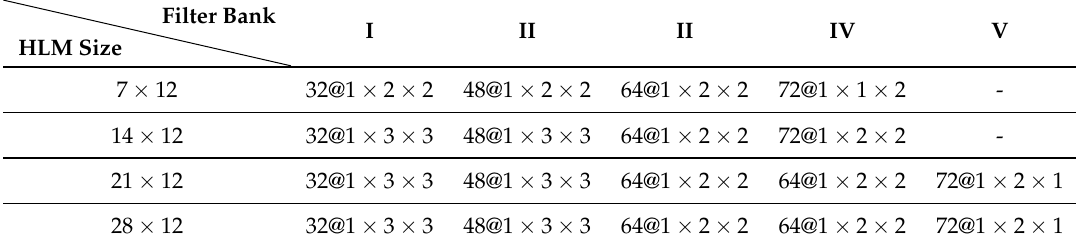
Table 1. Convolution settings for different